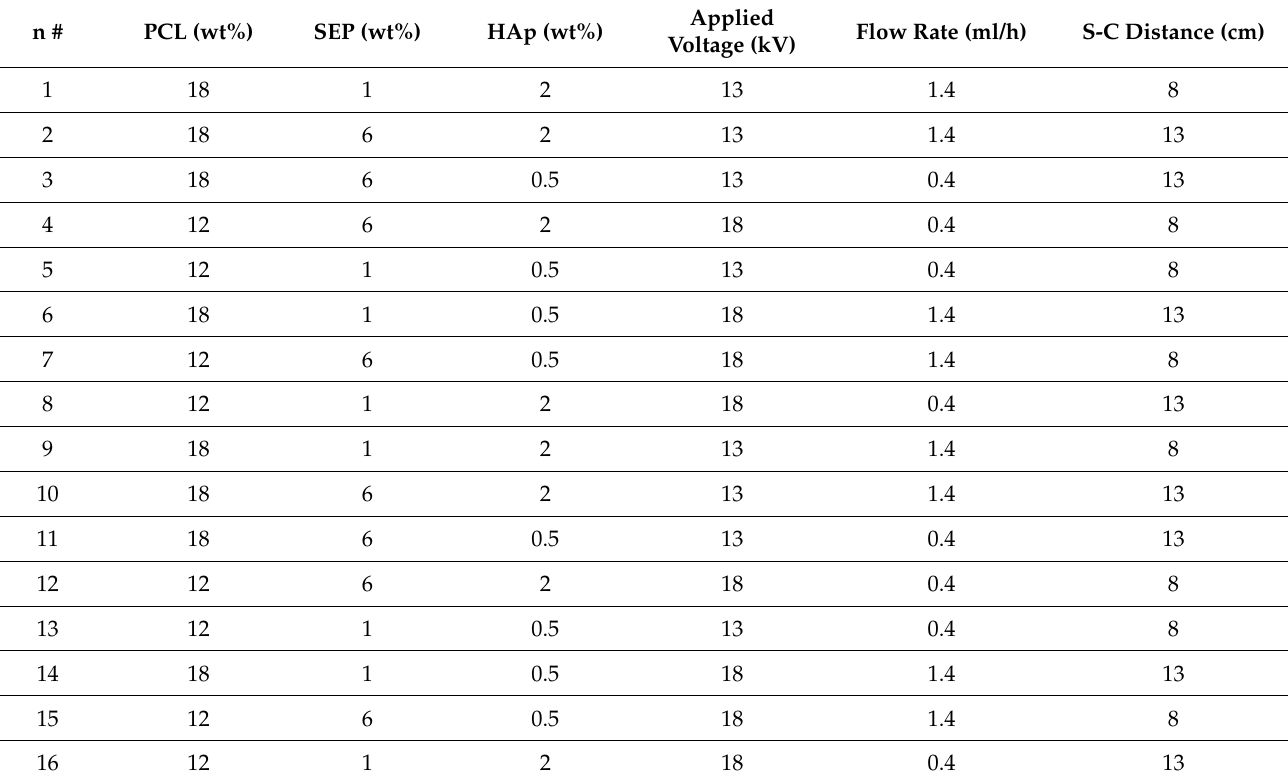
Table 4. The 16 specimen combinations of various input independent variables generated by